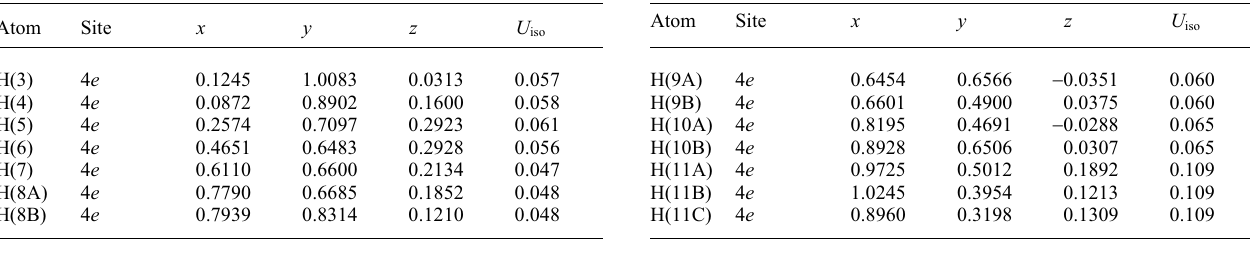
Table 3. Atomic coordinates and displacement parameters (in Å 2 ).